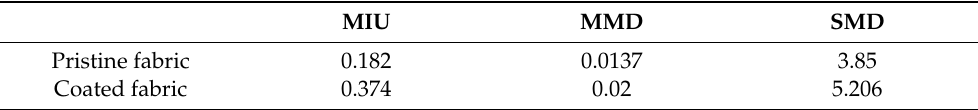
Table 2. Surface properties as determined by the Kawabata evaluation